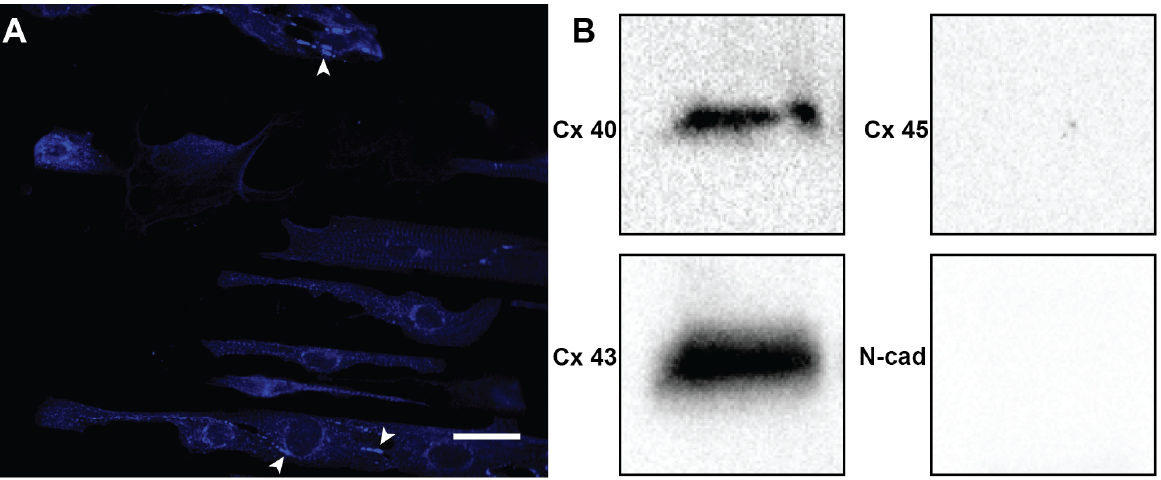
Figure 3. Intercellular junction presence. Cells stained for the presence of Connexin 43. ( A ) Example image a sampled stained for Connexin 43; Arrows indicate areas with noticeable connexin 43 junctions. Scale bar: 25 µm. ( B ) Western blot of connexins 40, 43, and 45 and